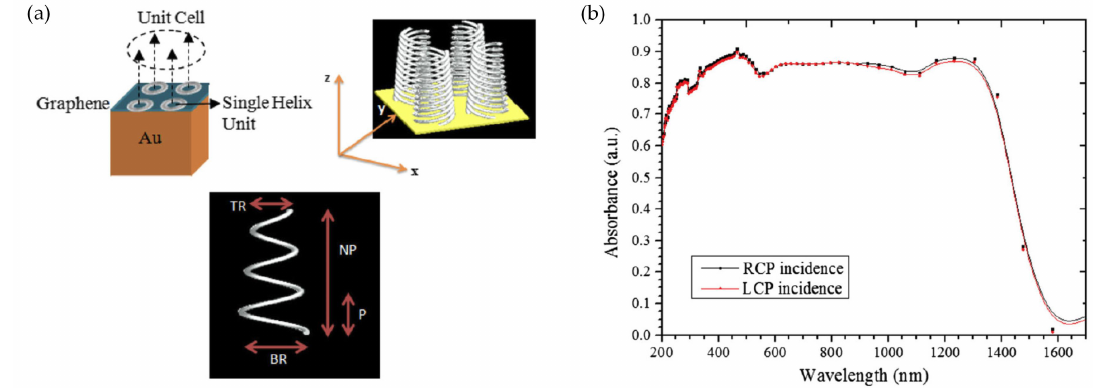
Figure 8. ( a ) schematic of graphene metasurface absorber with buried metallic helices; ( b ) the simulated absorption spectra for left- and right-circular polarized waves, reprinted with permission from Ref. [115].